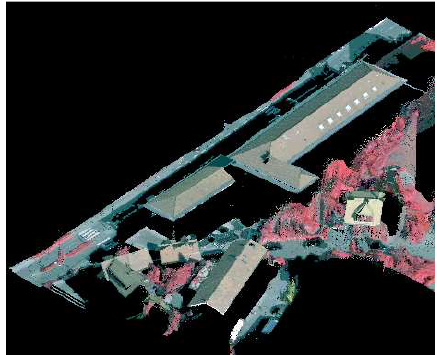
Figure 5. The figure shows the isometric view for area